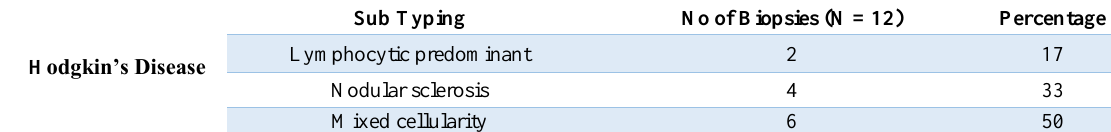
The expression of proliferative and apoptotic